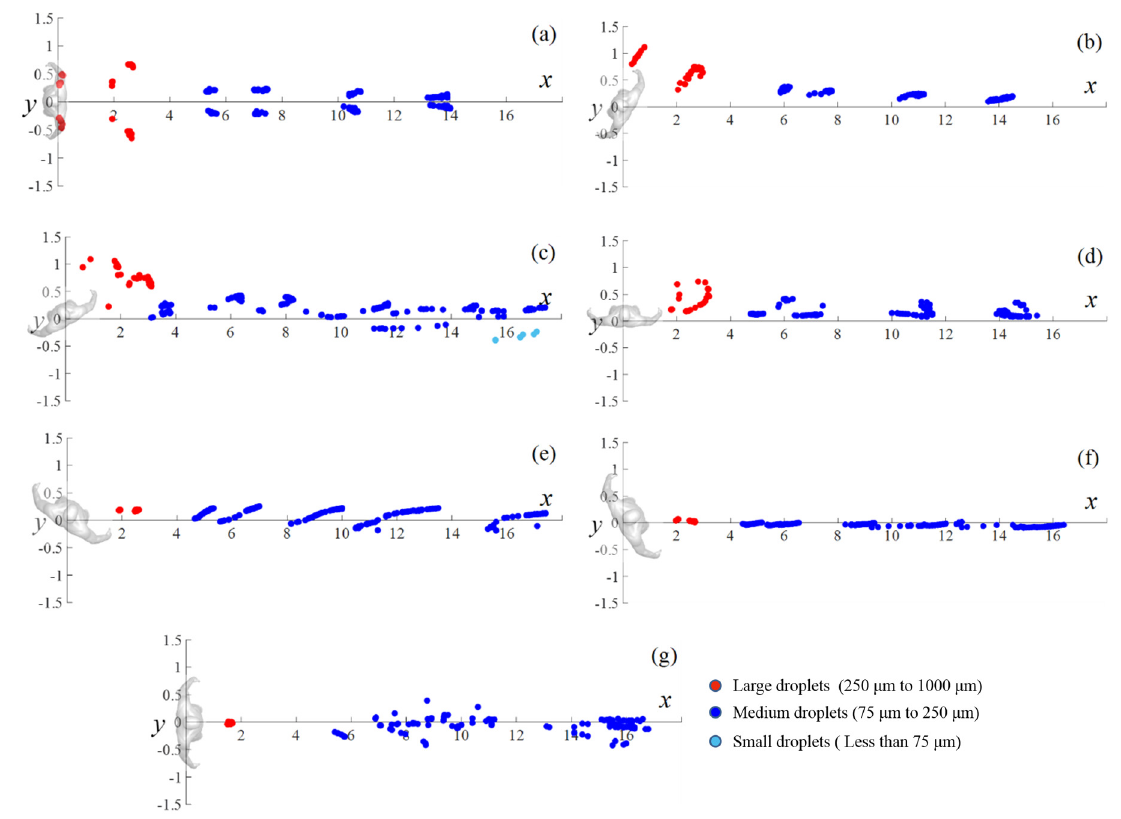
Figure 12. Deposition positions of droplets on the ground in different wind directions: ( a ) 0°, ( b ) 30°, ( c ) 60°, ( d ) 90°, ( e ) 120°, ( f ) 150°, and ( g ) 180°.